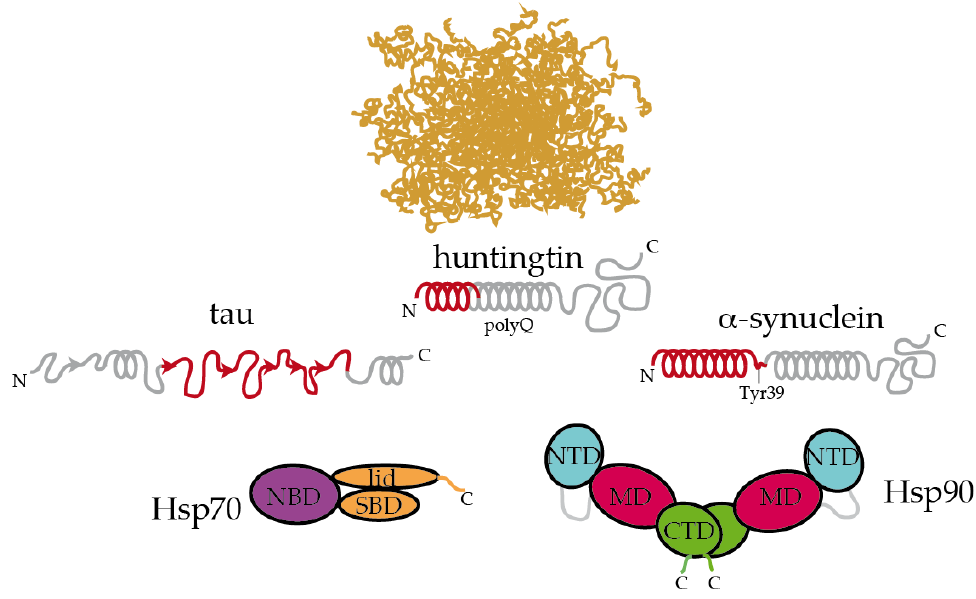
Figure 2. Hsp70 and Hsp90 recognize the structured moieties present in intrinsically disordered proteins (IDPs). A representative ensemble of conformations adopted by an IDP in solution is pictured at the top [94]. Tau, huntingtin, and α-synuclein contain elements that have a tendency to adopt a partial secondary structure (represented with helices and arrows for α-helices and β-strands, respectively) [83,88,89]. The moieties recognized by Hsp70 and Hsp90 are colored in red [26,34,86,89]. On tau, Hsp70 specifically recognizes the stretches 275 VQIINK 280 , 306 VQIVYK 311 , and 375 KLTFRE 380 [34]. The disordered C-terminal tails of Hsp70 and Hsp90 are represented. In Hsp90, the flexible, negatively charged linker connecting the NTD and the MD is represented with a grey line. The length of huntingtin is shortened for simplicity.